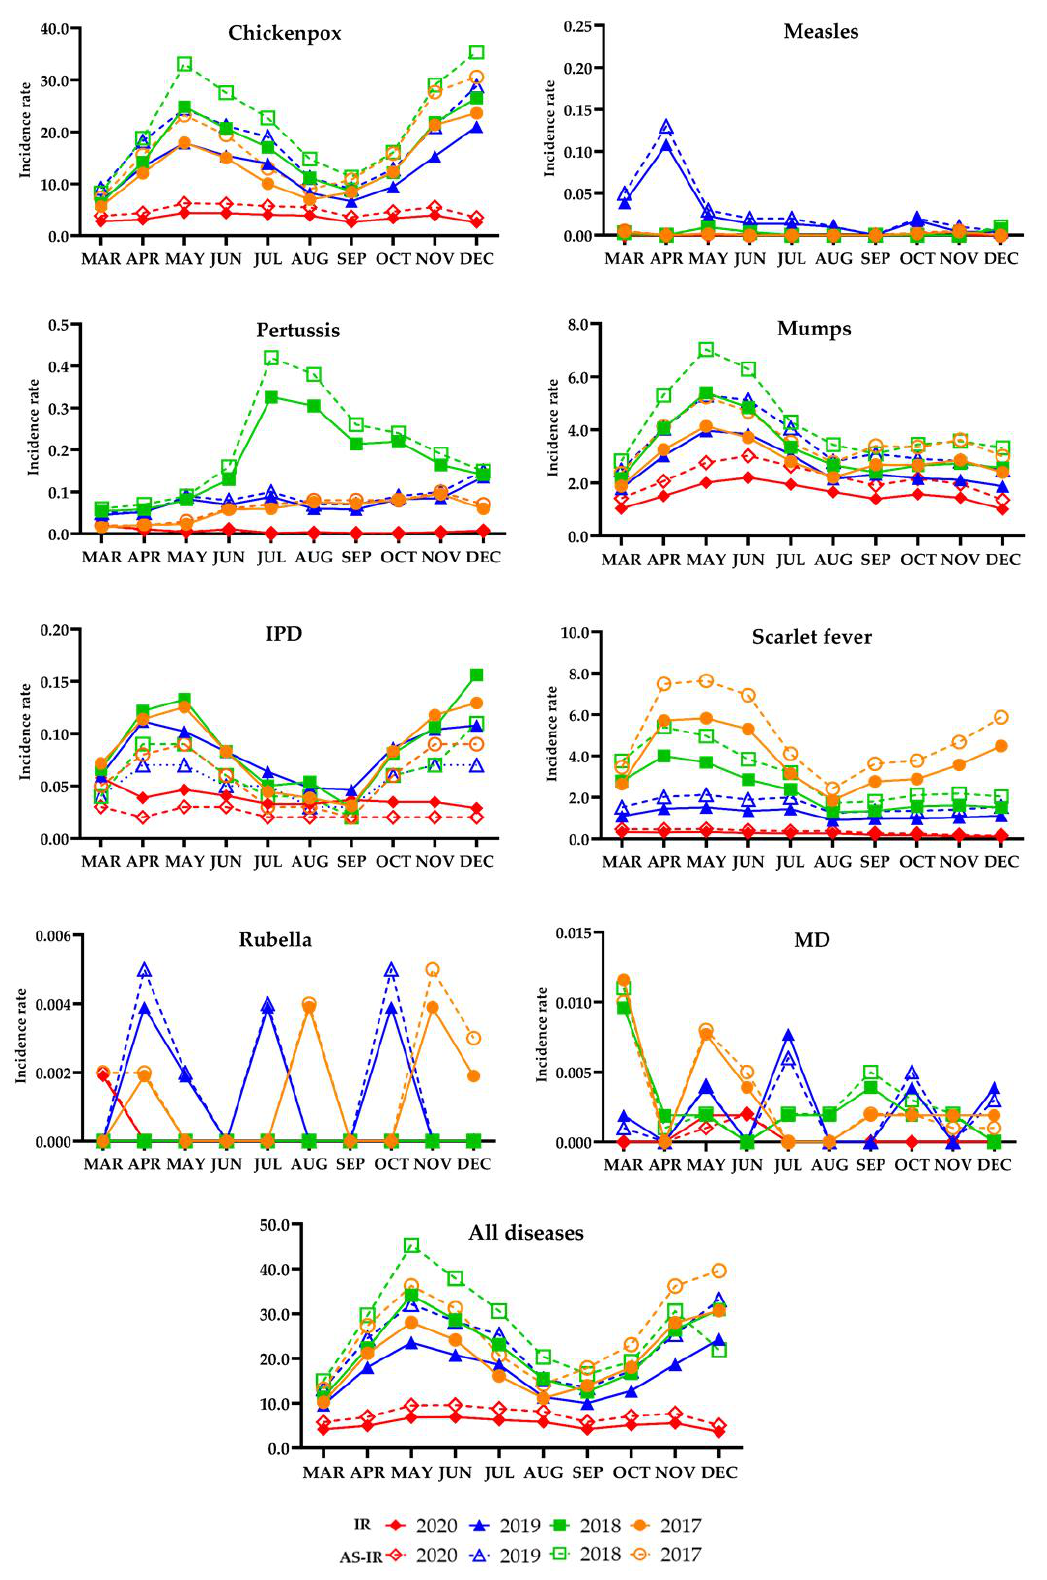
Figure 1. IR and AS-IR of infectious respiratory diseases by year. Units per every 100,000 people. For pertussis, all the monthly IRs and AS-IRs in the intervention period were signif- icantly smaller than those in the pre-intervention period, except for those in March and April 2017. The AS-IRs in July, August, and September 2018 were significantly